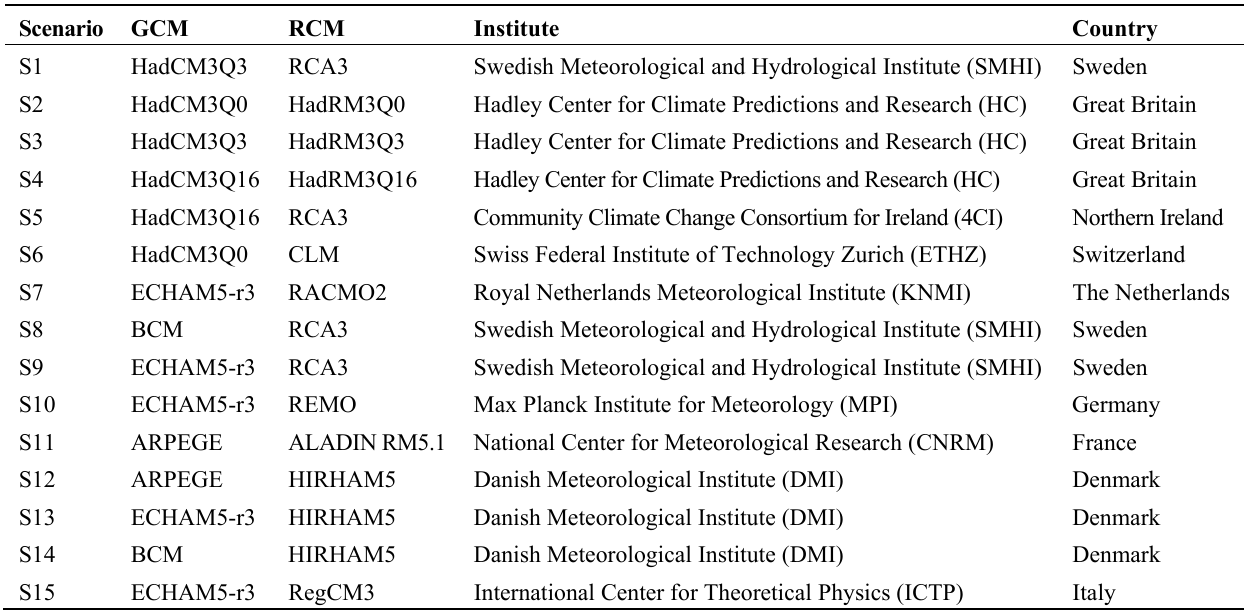
Table 3. Global (GCM) and Regional Climate Model (RCM) combinations and responsible institutes for the 15 ENSEMBLES climate scenarios (S1-S15) used for impact assessment in the case study